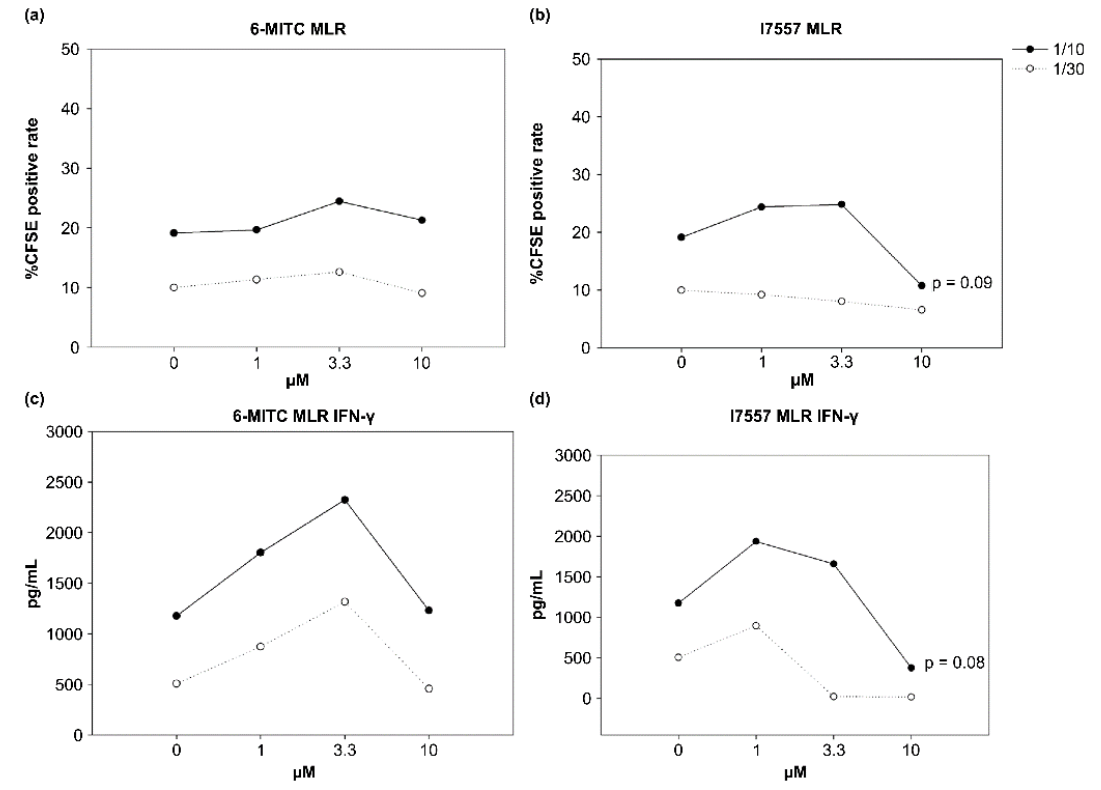
Figure 5. Proliferation and interferon (IFN)- γ secretion of allogeneic CD4 + CD45RA + naive T-cells stimulated by DCs generated in various cultures. CD4 + CD45RA + T-cell proliferation stimulated by 6-MITC and I7557-treated DCs as measured by carboxyfluorescein succinimidyl ester (CFSE) uptake. ( a , c ) No significant effects between 6-MITC-treated DCs and naïve T-cell; ( b , d ) Dual effect between I7557-treated DCs and T-cells.